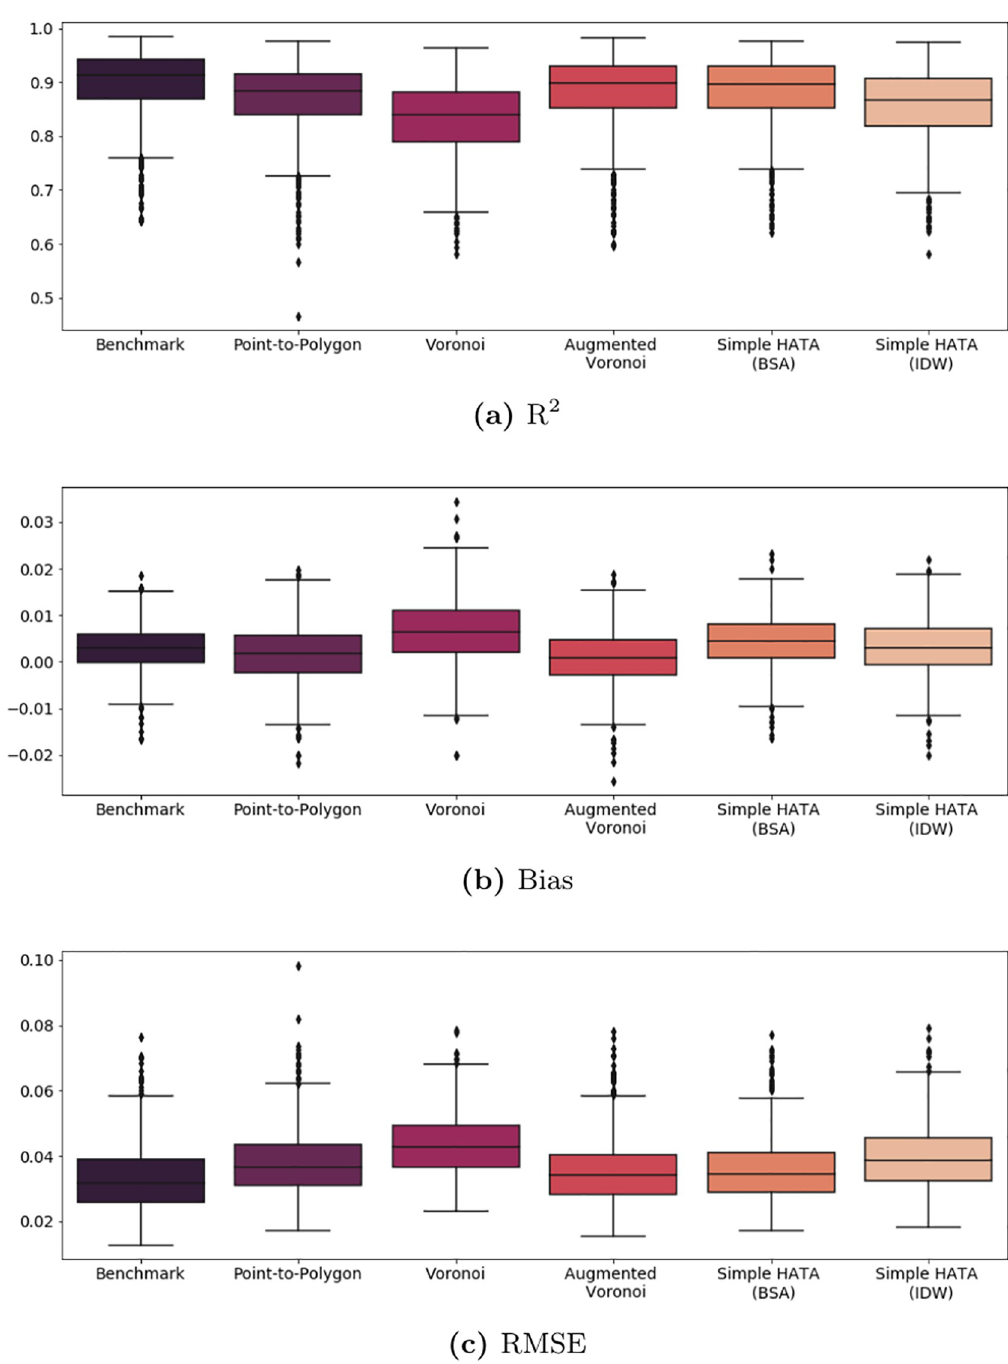
Fig 7. Estimating the true poverty rate for statistical areas. Distribution of the three performance metrics adjusted R 2 , bias and RMSE with the estimated poverty rate using the true coverage area, i.e. built-up areas perfectly allocated to BTS, as ‘Benchmark’ across 1000 simulation